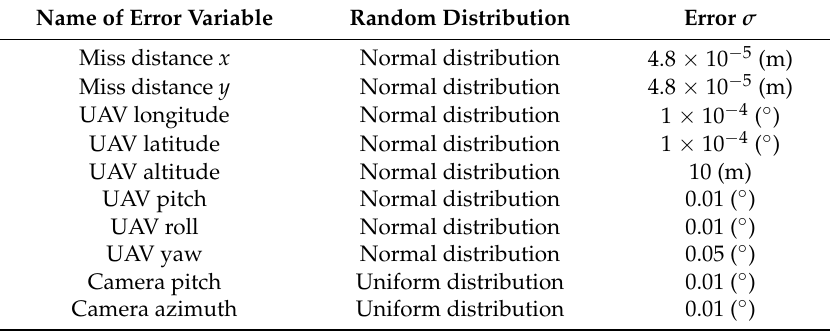
Table 1. Distribution of random errors.